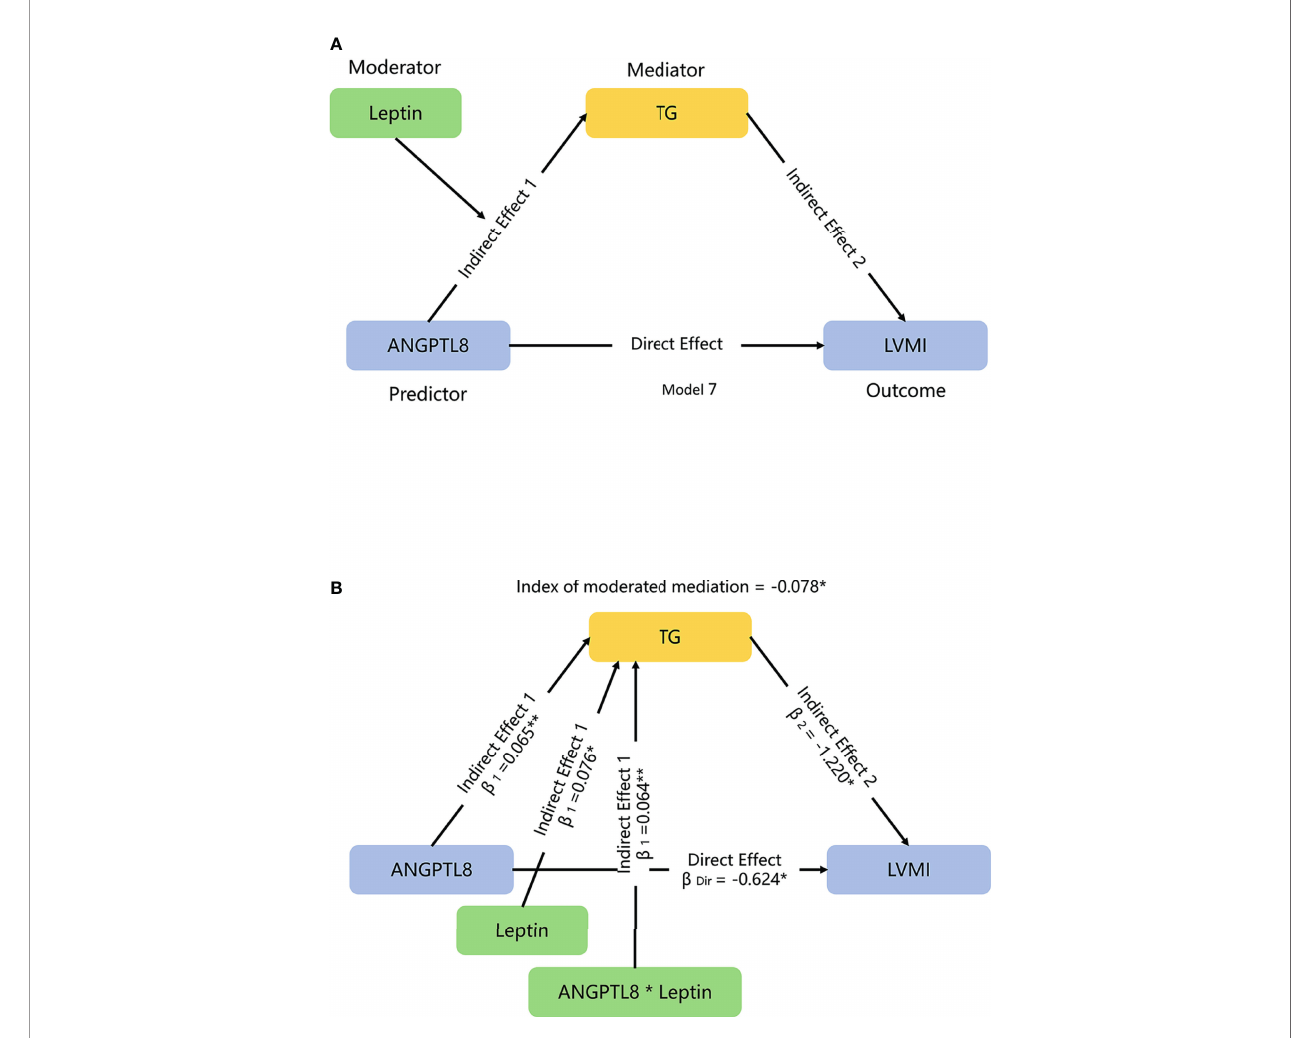
FIGURE 3 | The moderated-mediation model used to evaluate the effects of leptin and TG on ANGPTL8-LVMI association. (A) We hypothesized that leptin might modulate the mediation effects of triglyceride (TG) on the association of ANGPTL8 and left ventricular mass index (LVMI) in a moderated mediation template model 7. (B) Moderated effect of leptin for TG is signi fi cant, with increment of 0.064 mmol/L TG each additional ln-leptin z-score; the index of moderated mediation, which qualify the relationship between moderator leptin and the size of the indirect effect of ANGPTL8 on LVMI through mediator TG, was signi fi cant, with a 0.078 g/m 2.7 lower LVMI each additional ln-leptin z-score at a given level of ANGPTL8. Mediation and moderation effects were adjusted for age, sex, body mass index, and systolic blood pressure. b =standardized regression coef fi cient; b 1 = indirect effect 1; b 2 = indirect effect 2; b Dir = direct effect. Data based on 5000 bootstrap samples. Ln-transformed for TG, ANGPTL8 and leptin, per z-score interaction of each ln-adipokine/hepatokine. * P < 0.05; ** P < 0.01.